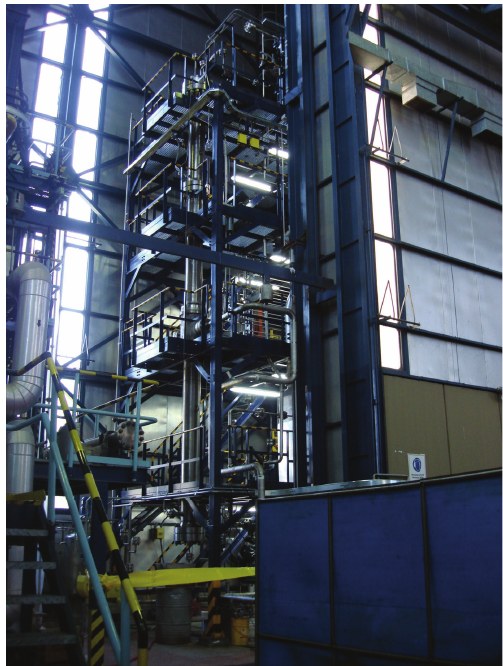
Figure 6: High-pressure and high-temperature